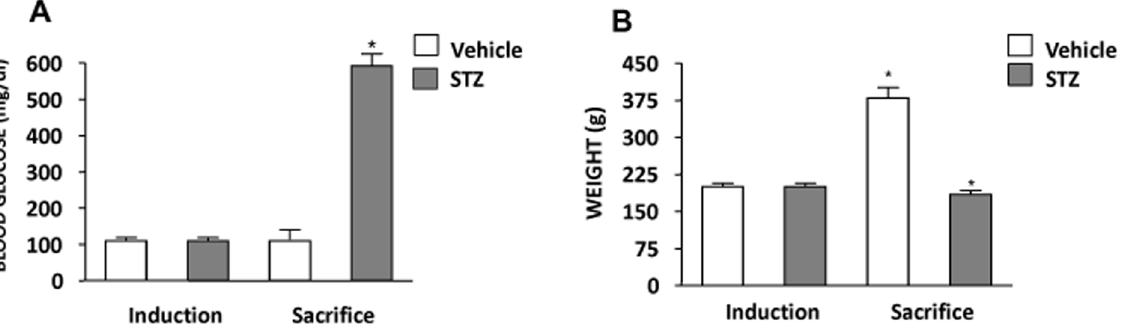
Figure 1. Experimental diabetes model. ( A ) Glycemia values and ( B ) body weight at baseline and 4 weeks post diabetes induction using 65 mg/ Kg streptozotocin (STZ) in 2-months-old Sprague-Dawley rats. Values are mean 6 SEM (n=6). * p , 0.0001 vs